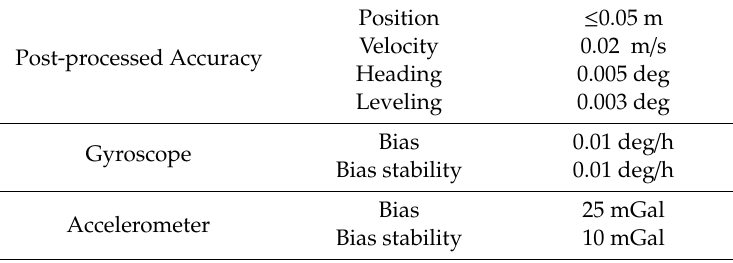
Table 2. POS830 reference system performance parameters.